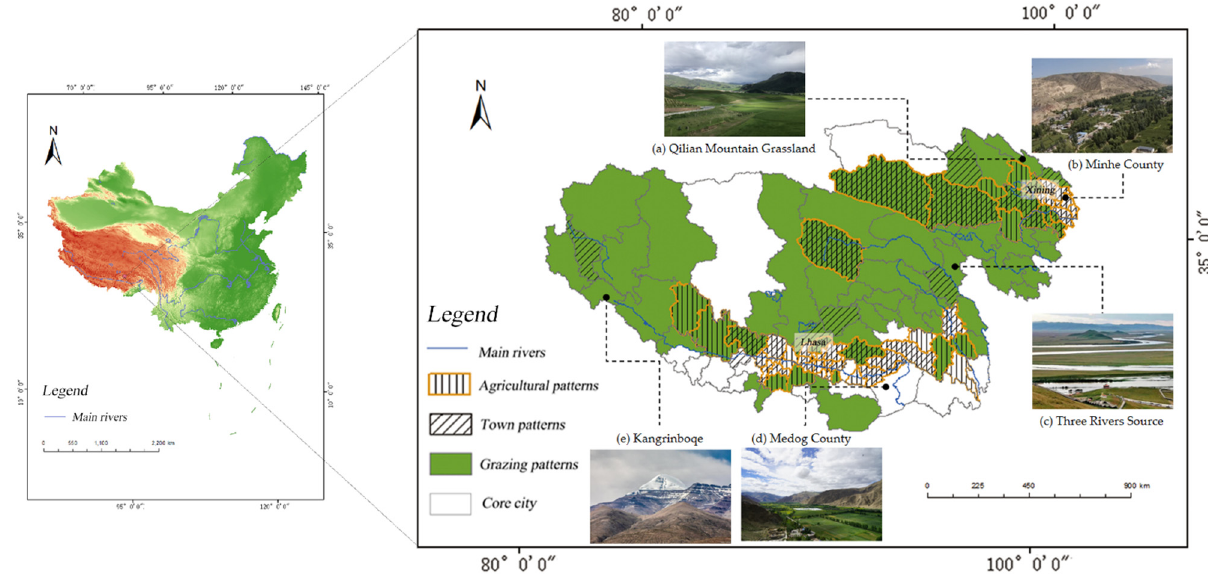
Figure 1. The overview of the study area.